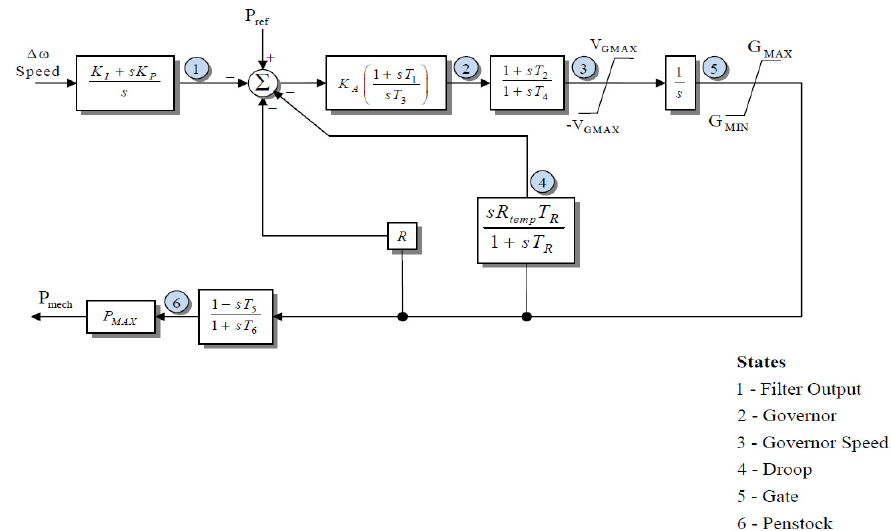
Figure 3. Typical model of the Hydro Turbine-Governor system. (The parameters are defined in the literature [27]).